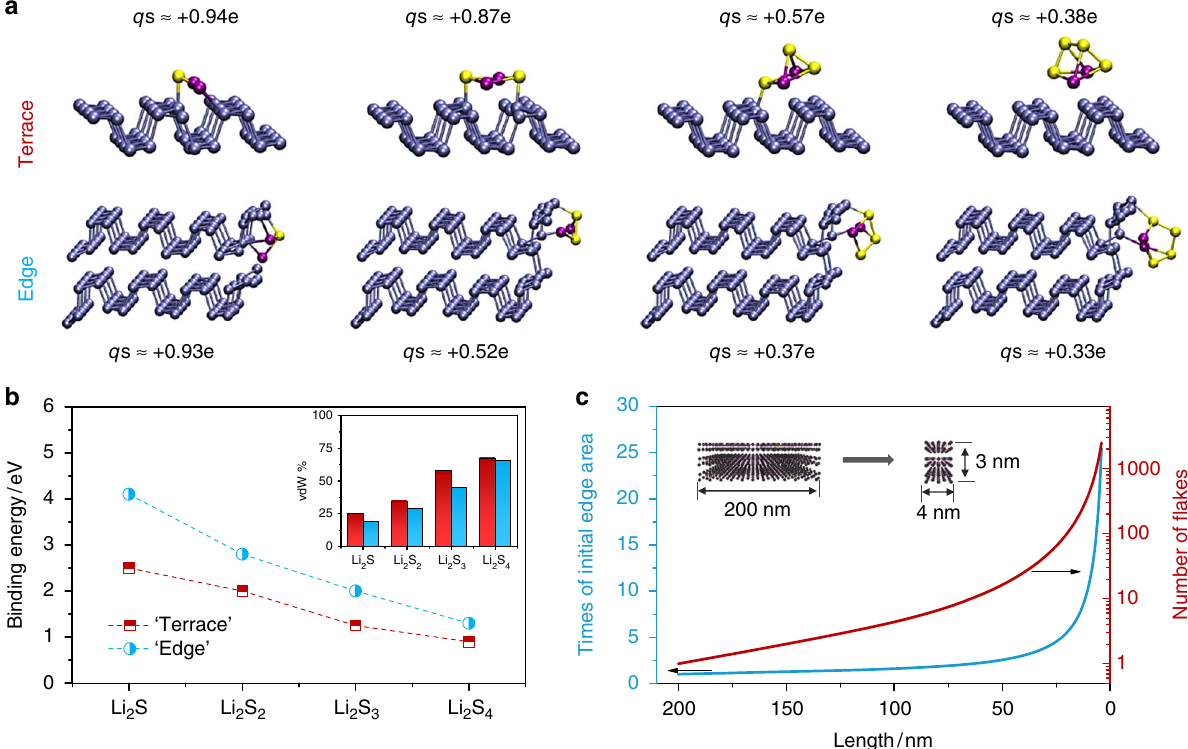
Fig. 3 Calculation of lithium polysul fi de adsorption on black phosphorus fl akes. a Snapshots of lithium polysul fi des (LiPSs) adsorbed on terrace and edge sites of black phosphorus (BP) monolayer and nanoribbons, respectively. The partial charge on the sulfur atom is de fi ned as qs , b binding energies of LiPSs adsorbed on terrace and edge sites of BP, the inset shows the fraction of van der Waals (vdW) contribution to the bond, c the increase of exposed edge area and the number of fl akes by downsizing a large BP fl ake to black phosphorus quantum dots